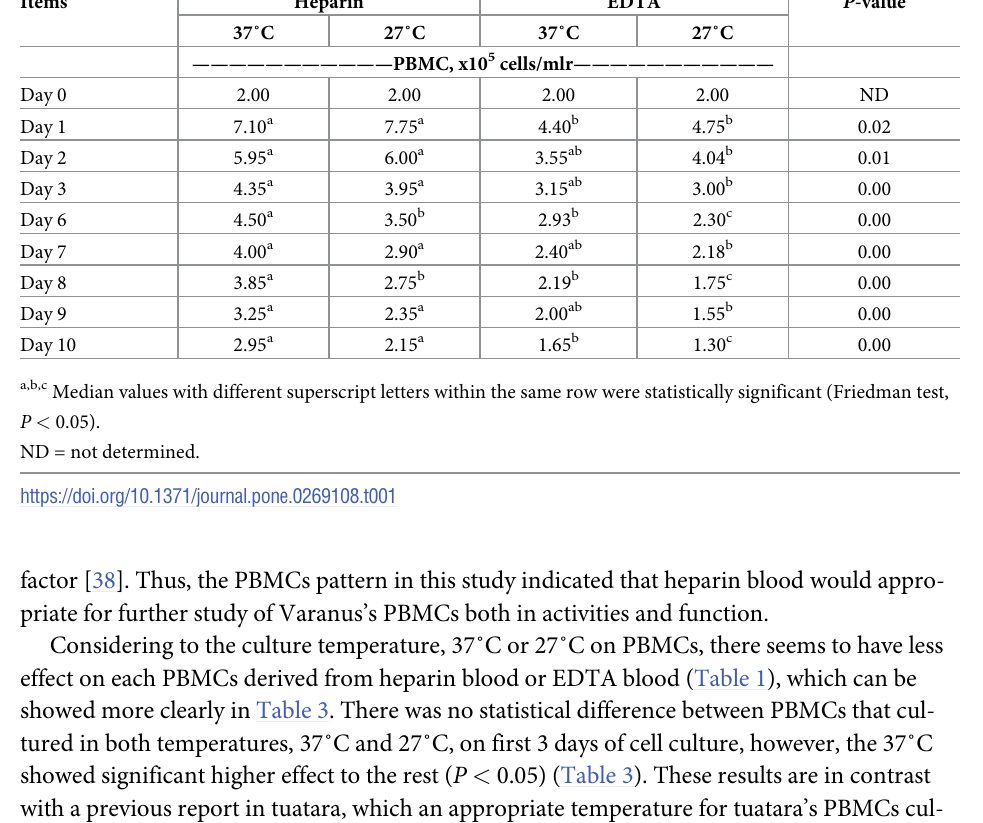
Table 1. Effect of either blood anticoagulants or culture temperatures on the peripheral blood mononuclear cells (PBMCs) isolation in Varanus salvator . Items Heparin EDTA